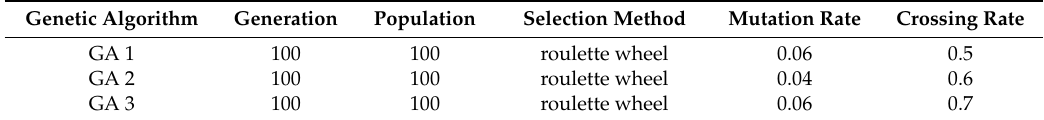
Table 4. Some of the parameters that were tested before choosing the optimal parameters for the GA. Genetic